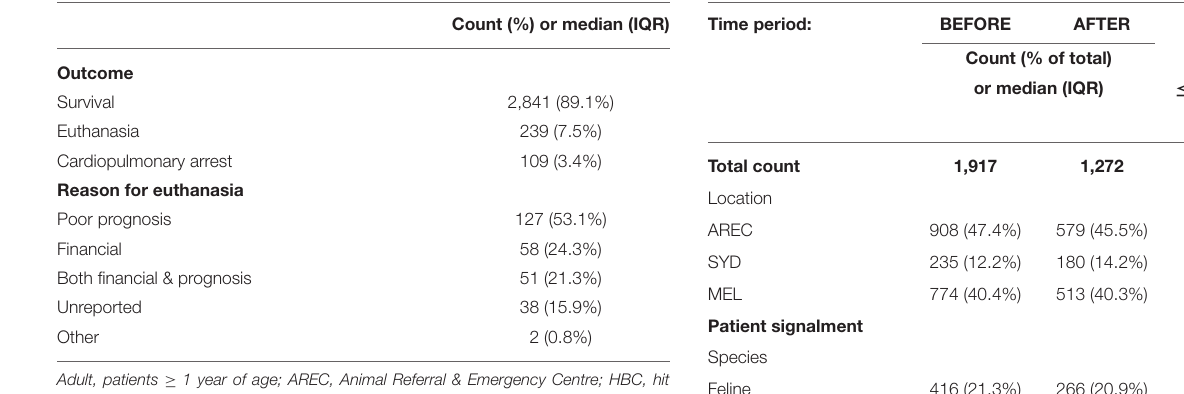
TABLE 2 | Patient characteristics, interventions, and outcomes by time